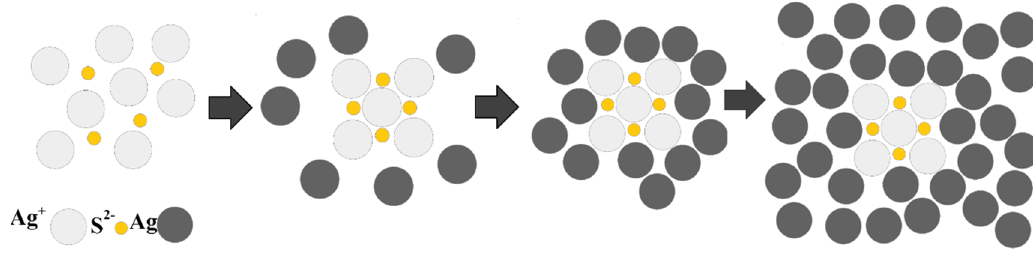
Figure 1. Scheme of synthesis of silver nanocubes.